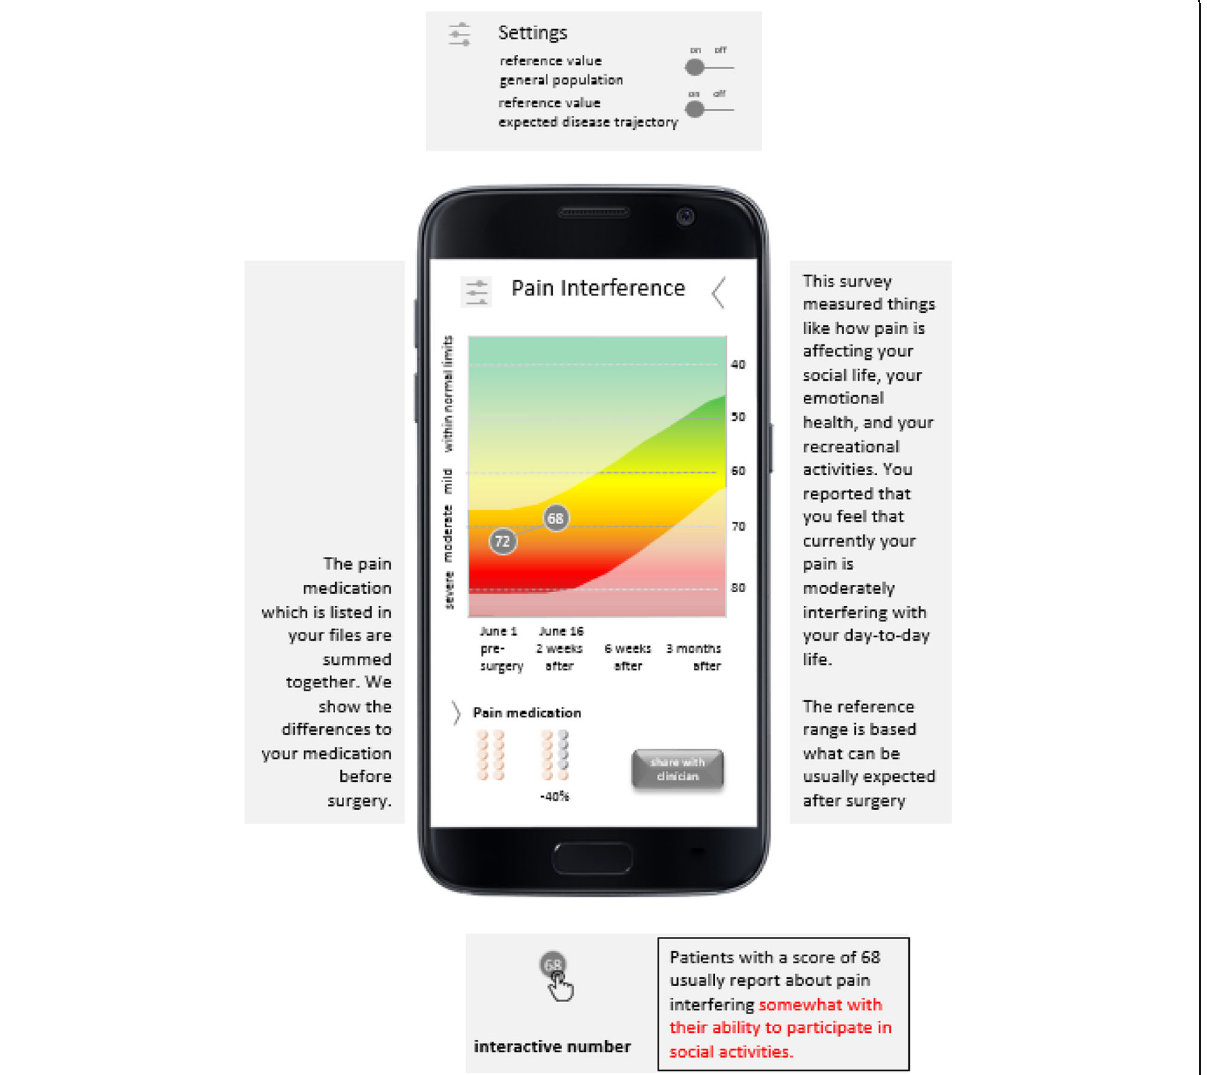
Fig. 2 Preliminary version of the graphical PRO feedback reports for the health domain of Pain